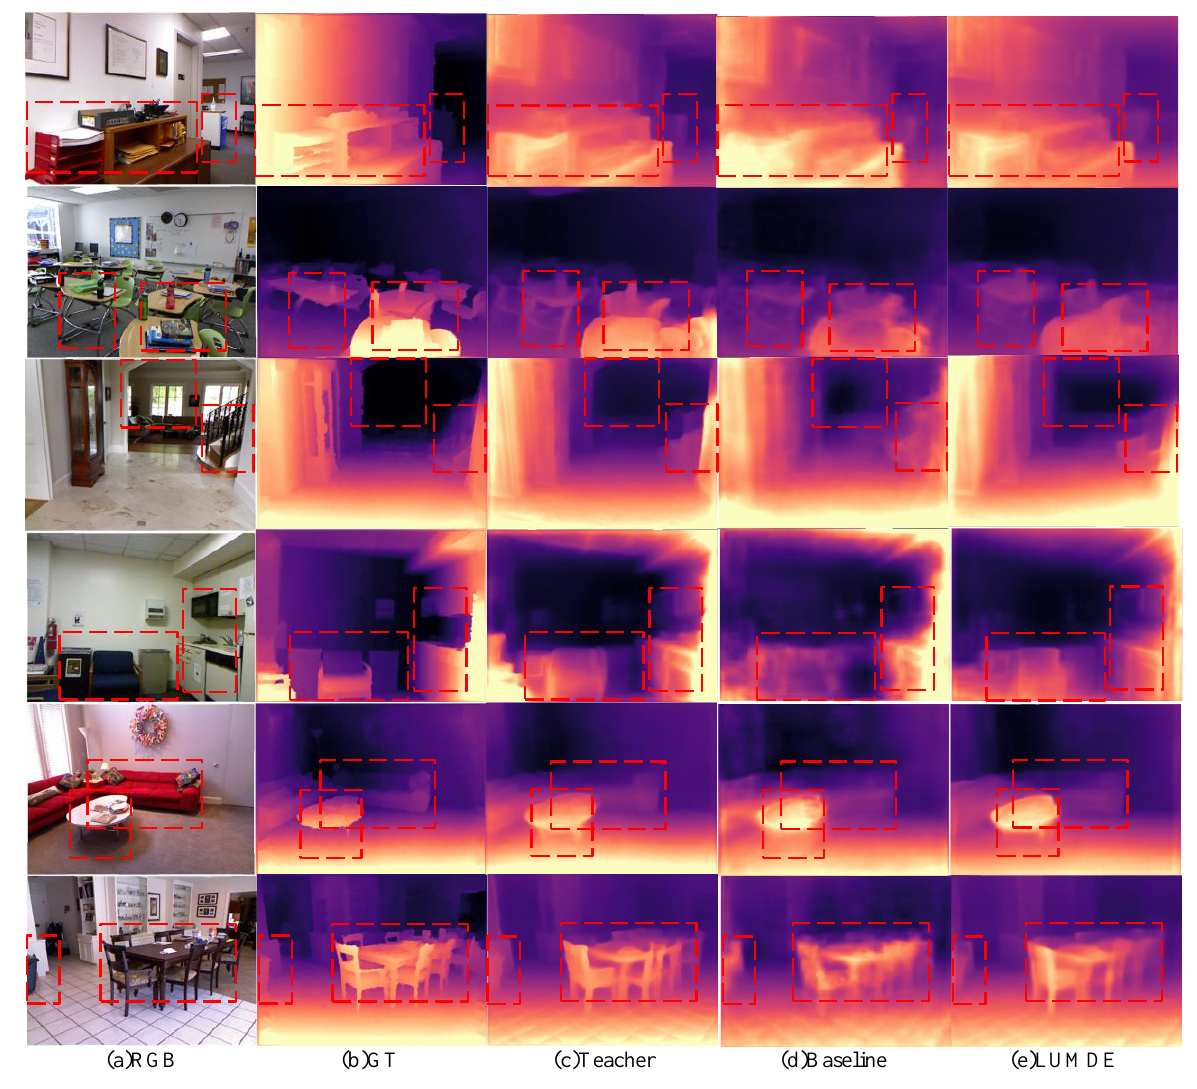
Figure 2. Qualitative comparison of depth ground truth, depth from teacher network, baseline, and LUMDE of indoor scenes, with RGB images shown in the first column.